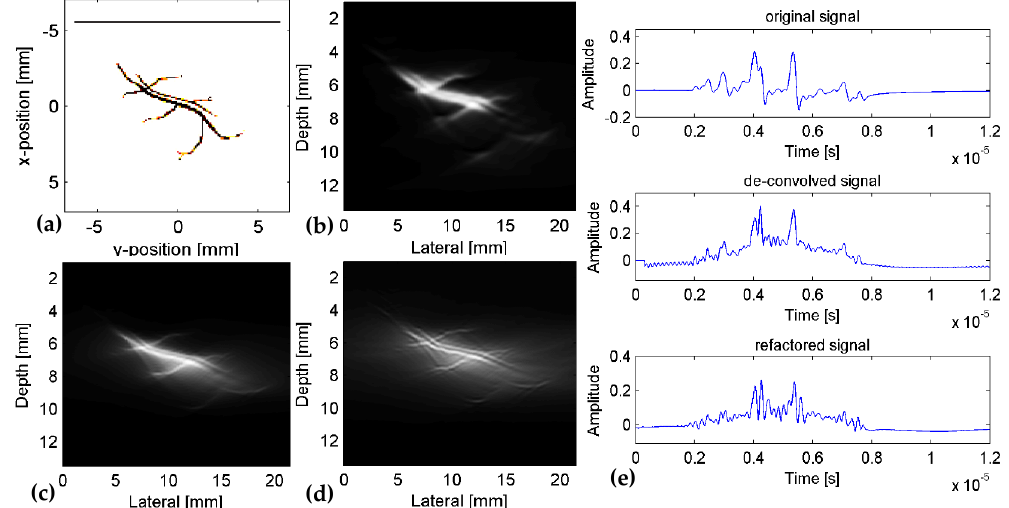
Figure 3. Results of the signal processing and reconstruction in complex numeric phantom. ( a ) the set position of source and sensors; ( b ) reconstructed image of original signal; ( c ) reconstructed image of de-convolved signal; ( d ) reconstructed image of final processed signal; ( e ) signal processing result.